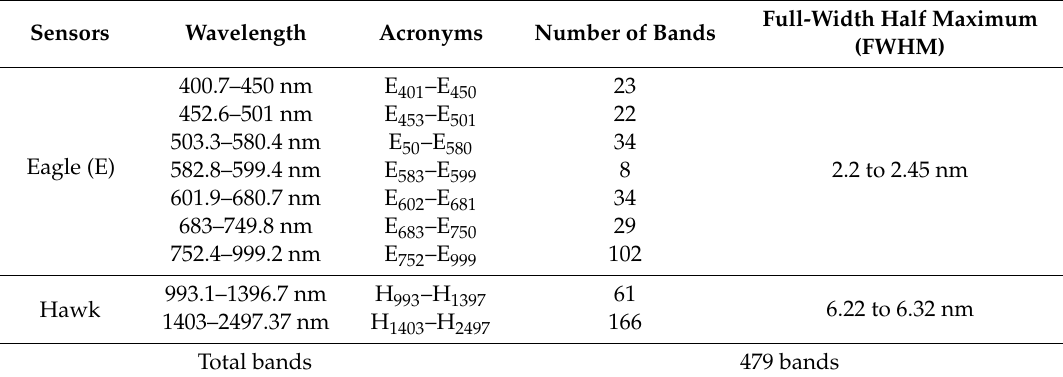
Table 2. Hyperspectral metrics variable acronyms with values representing the center of